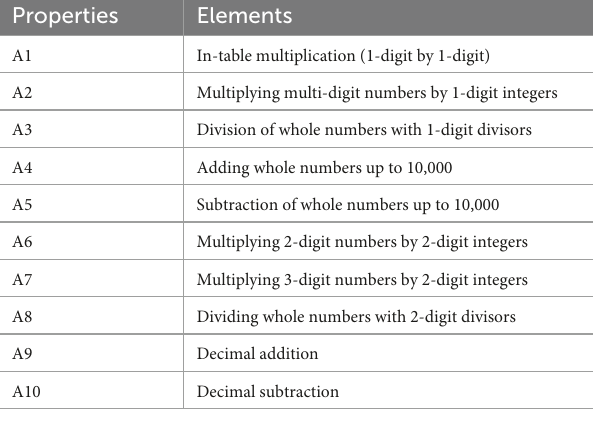
TABLE 2 Attributes of mathematical ability.